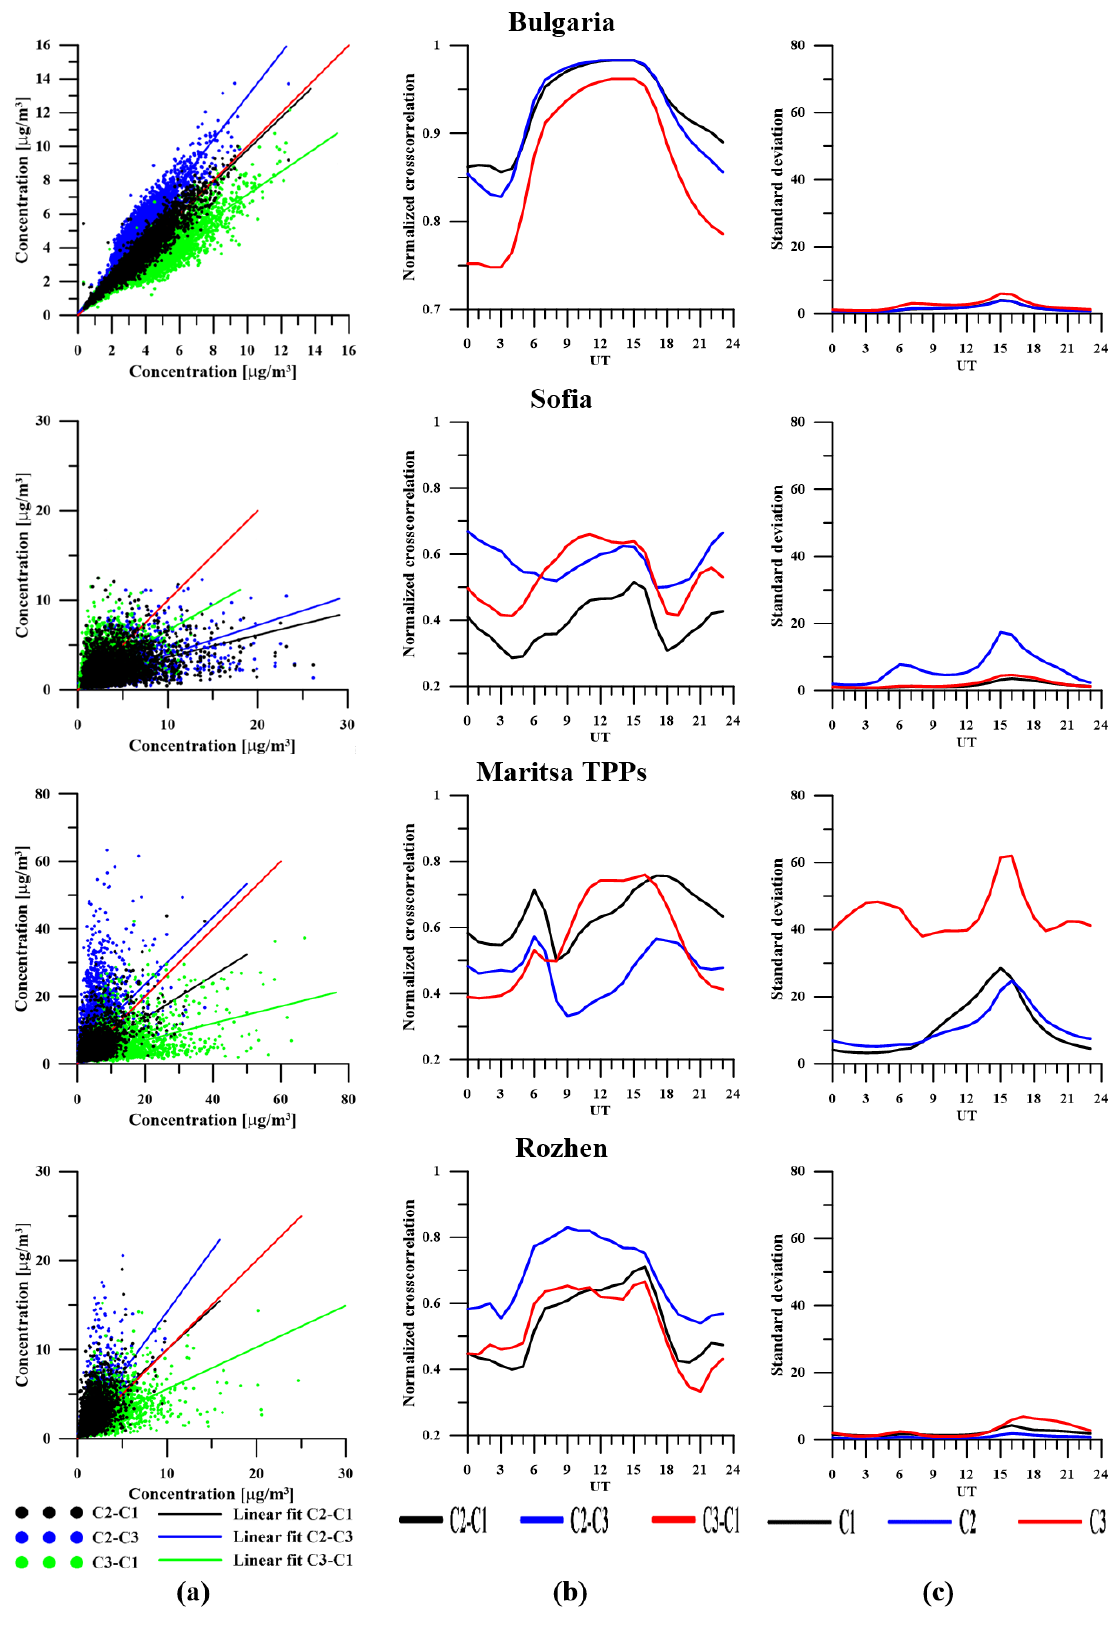
Figure 10. Comparisons of the regression ( a ) and correlations ( b ) and standard deviation ( c ) for NO 2 for the three cases.